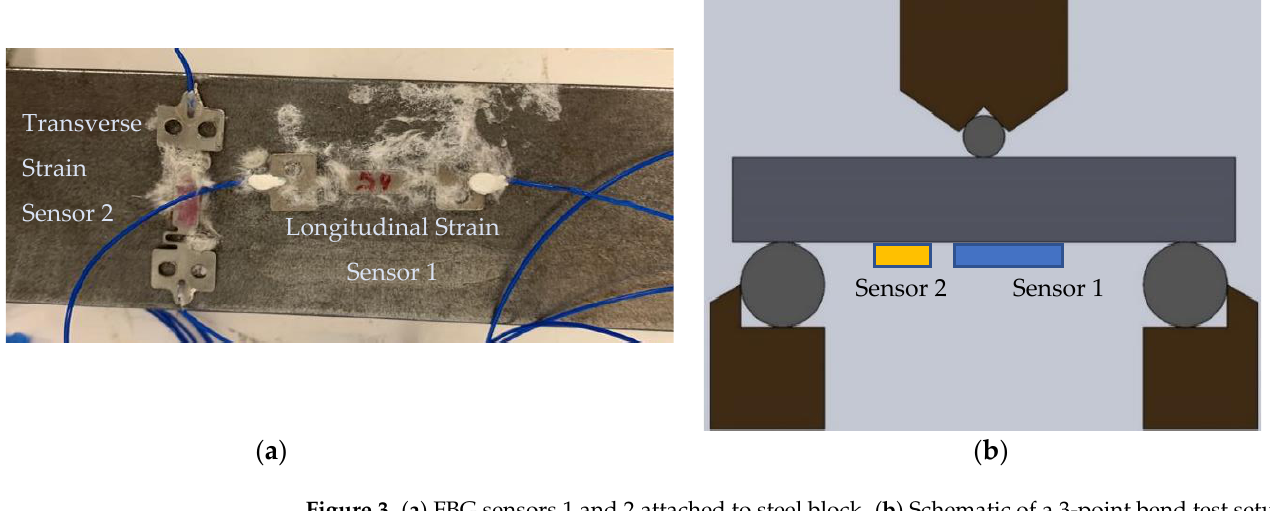
Figure 3. ( a ) FBG sensors 1 and 2 attached to steel block. ( b ) Schematic of a 3-point bend test setup with both sensors.